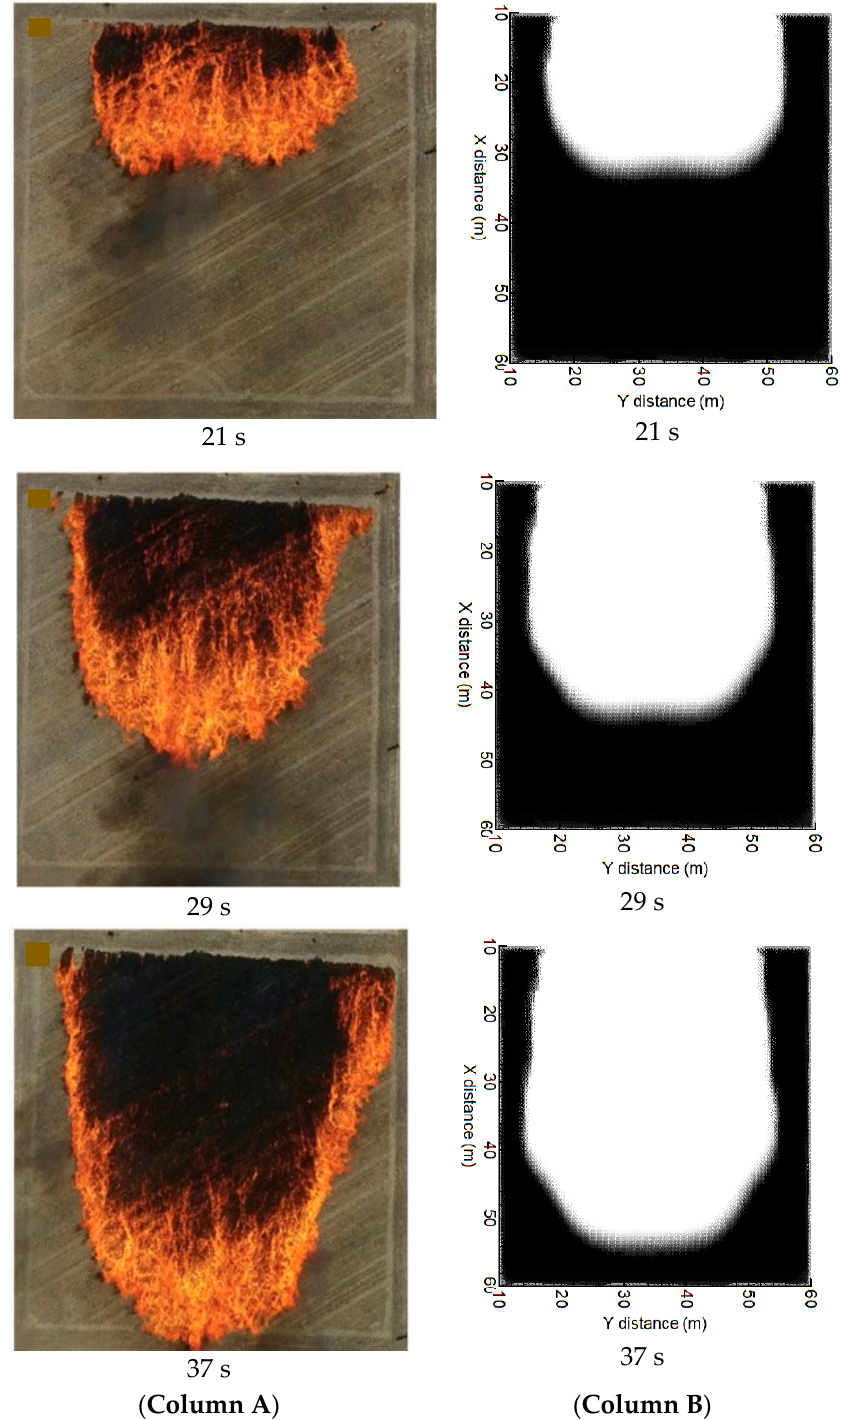
Figure 4. Image and simulation of the fire contour of the WH21 experimental: ( Column A ) aerial view